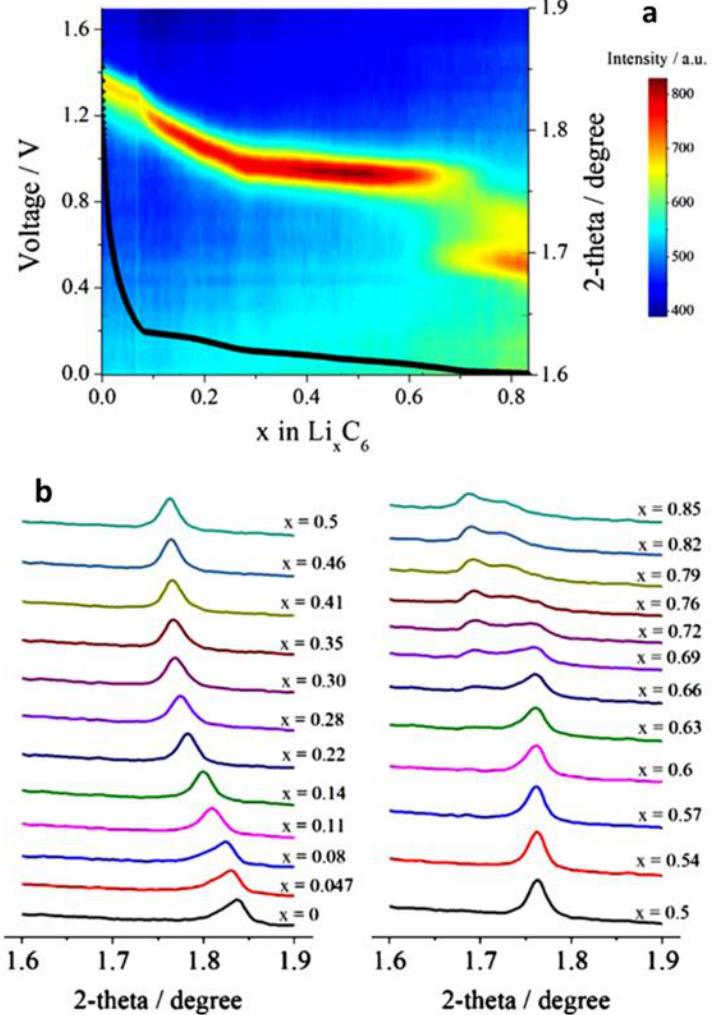
Figure 11. ( a ) Contour plot of XRD patterns and discharge curve from the Li/graphite cell discharged from 1.53 to 0.001 V at 1/3 C. ( b ) XRD patterns at 2θ between 1.6 and 1.9° showing the shift and split of graphite (002) peak as a function of x in Li x C 6 [119], with permission from Elsevier. Graphite Anode in Sodium-ion Battery